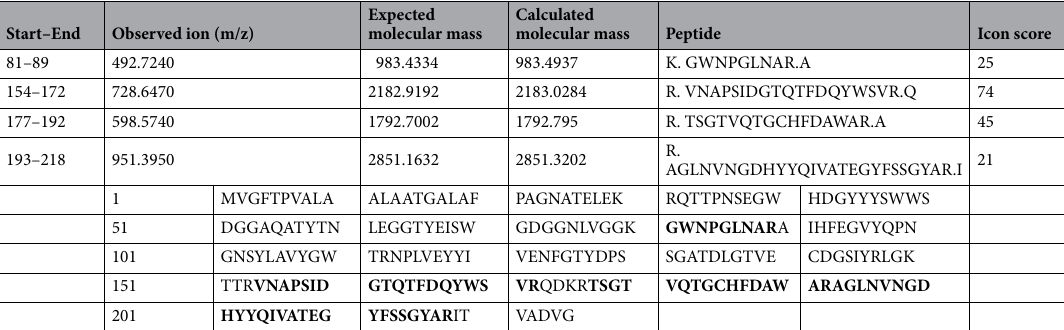
Table 2. Protein sequence of purified xylanase from Thermomyces dupontii KKU–CLD–E2–3. Protein sequence coverage of 31% indicated identity or extensive homology ( P < 0.05). Bold letters show the matched